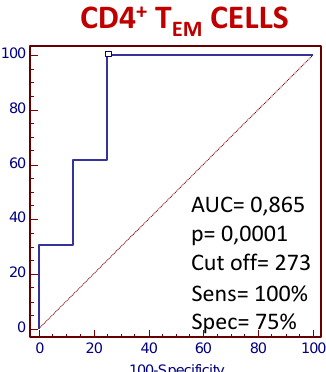
Figure 5. The receiver-operating characteristic (ROC) analysis of the counts of circulating CD4 + TEM